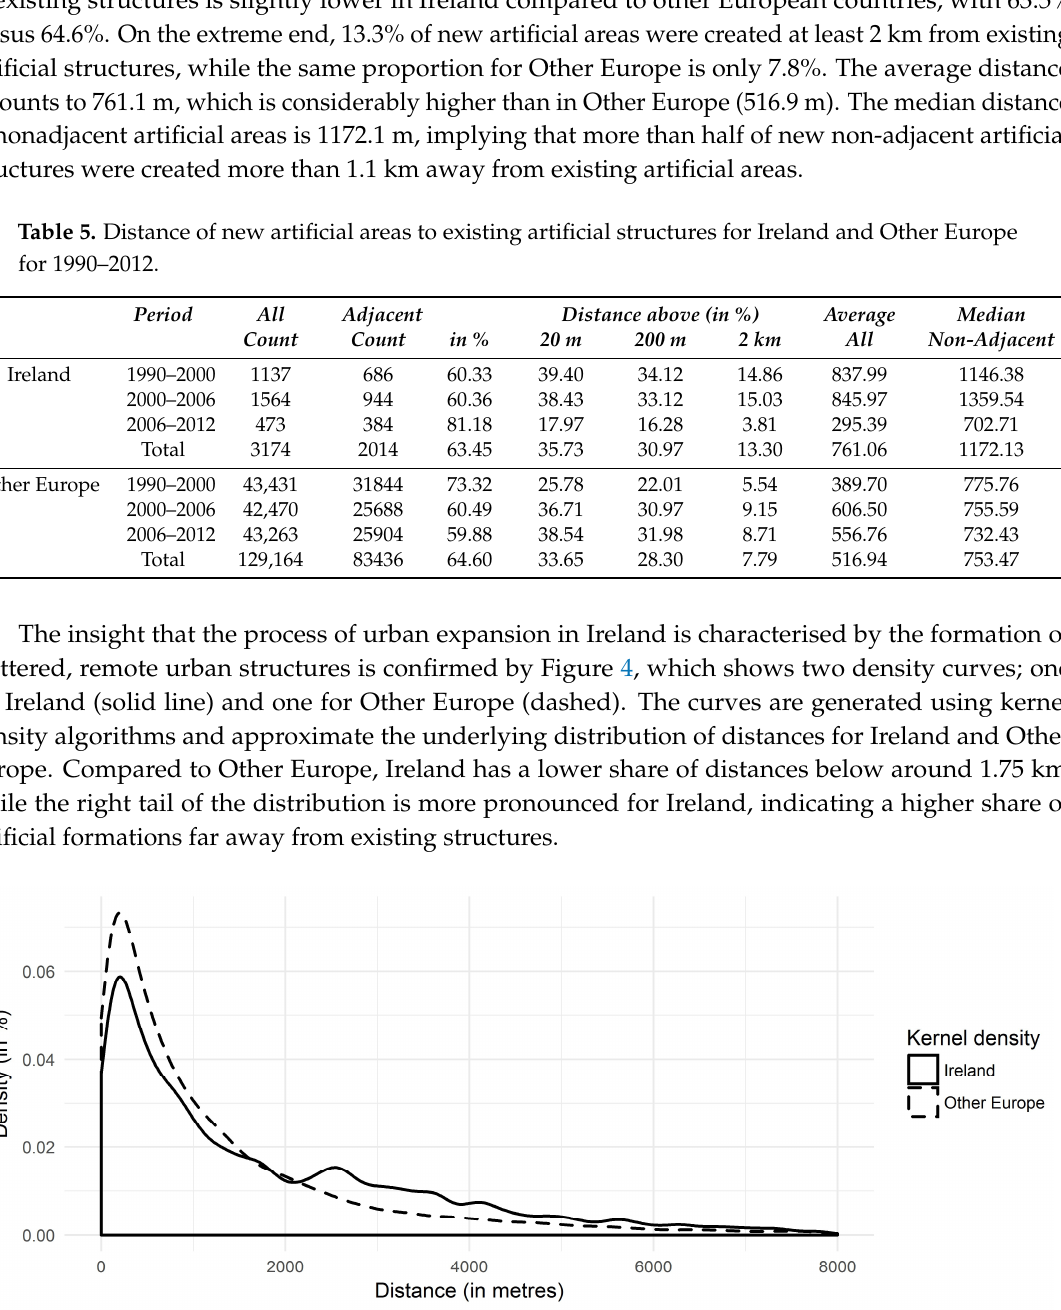
Figure 4. Distance of new artificial areas to existing artificial structures for Ireland and Other Europe for 1990–2012.